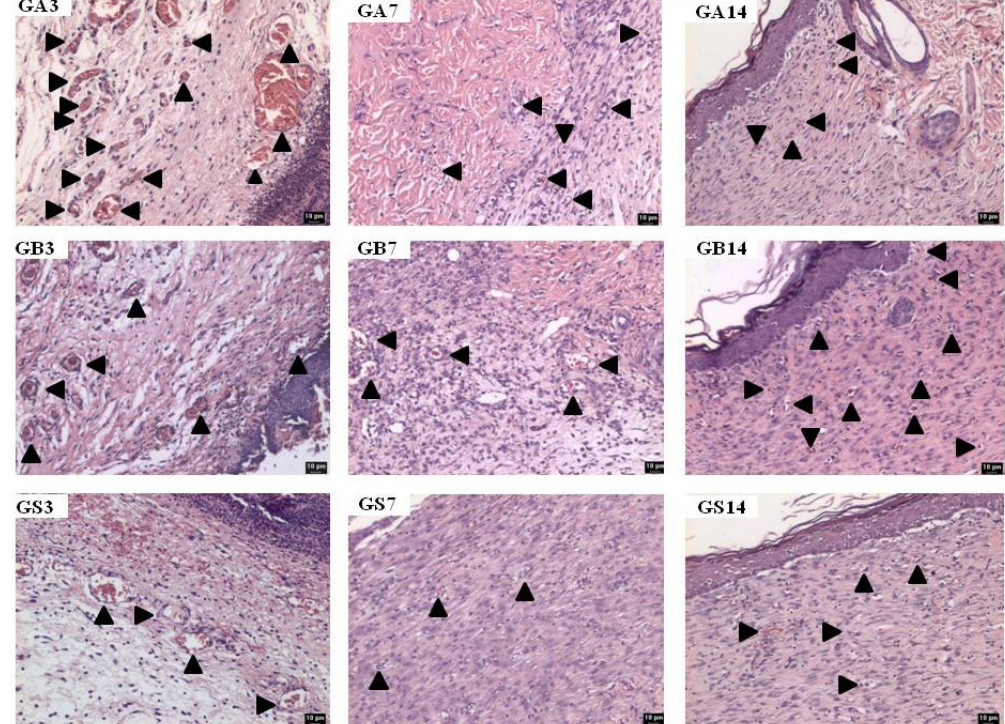
Figure 2 - Angiogenesis in the HG, LG and SG on the 3, 7 and 14 PO days (neoformed vessels shown by the arrows). Note: HG = High Frequency Group. LG = Low Frequency Group. SG = Simulated Group. PO =